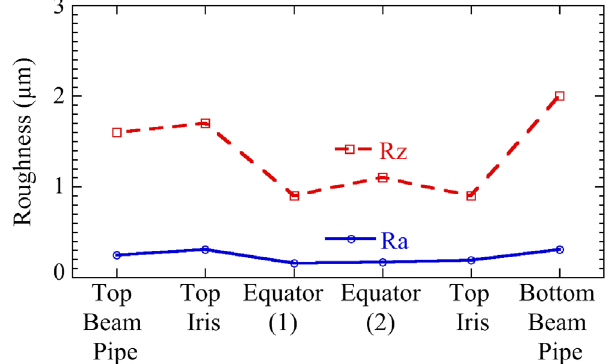
FIG. 6. Surface roughness Ra and Rz of the coupon surfaces after VEP performed at 12.5 V, a cathode rotation of 20 rpm, and a cavity temperature below 16 °C.